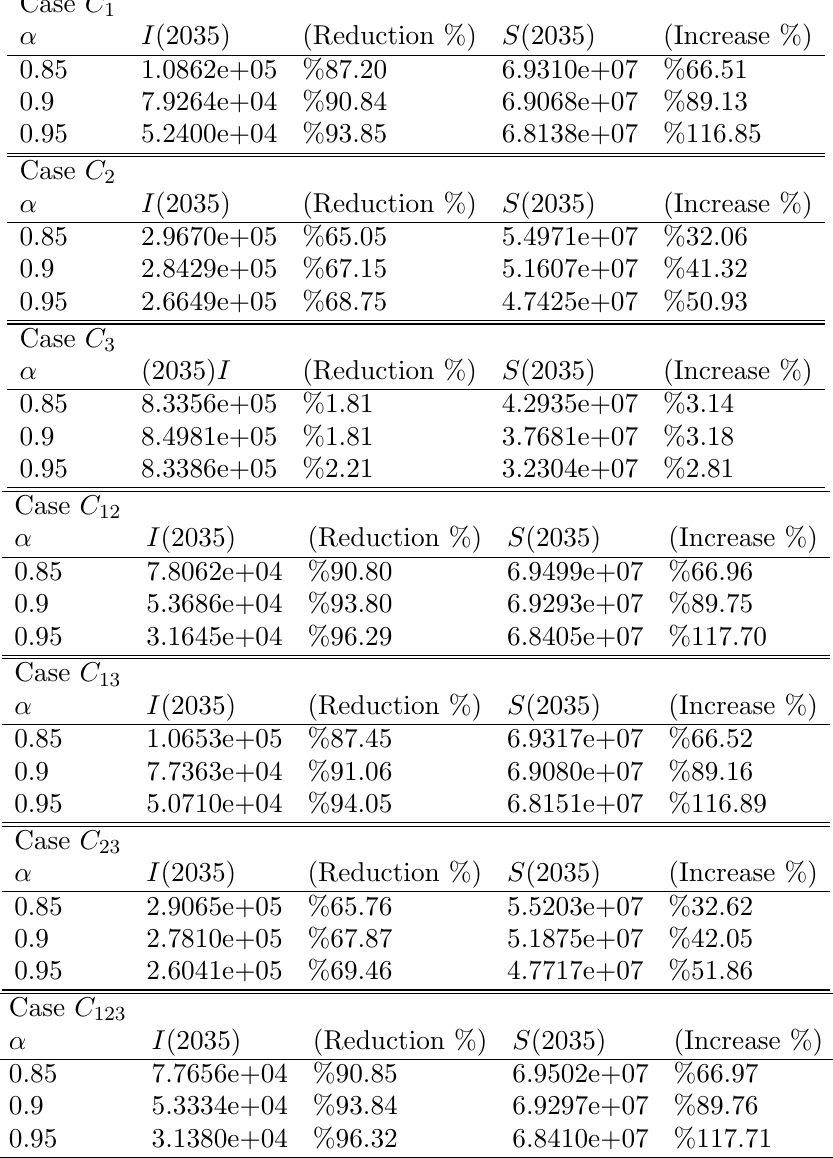
Table 3. Estimates for I ( t ) and S ( t ) in 2035 and the corresponding reduction/increase. Case C